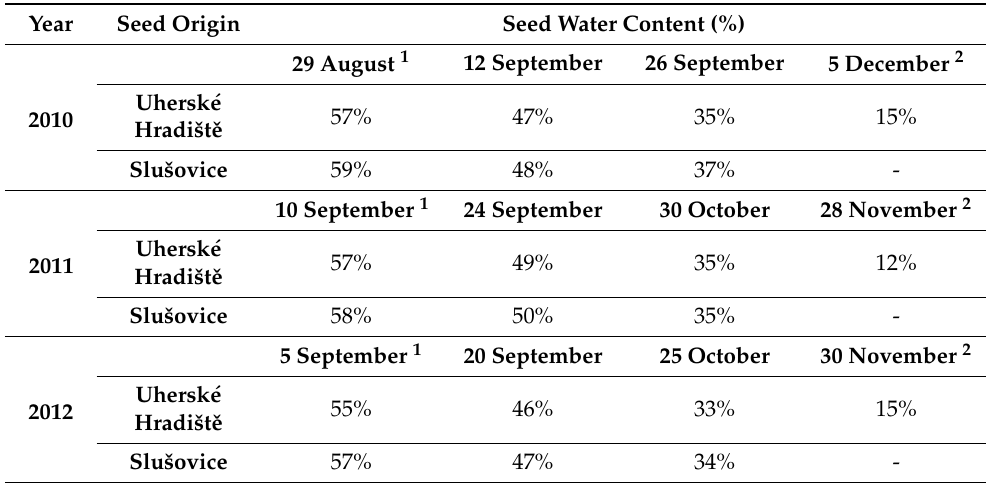
Table 1. Water content (%) of seeds during the maturation, on the trees of both origins, in different years of the